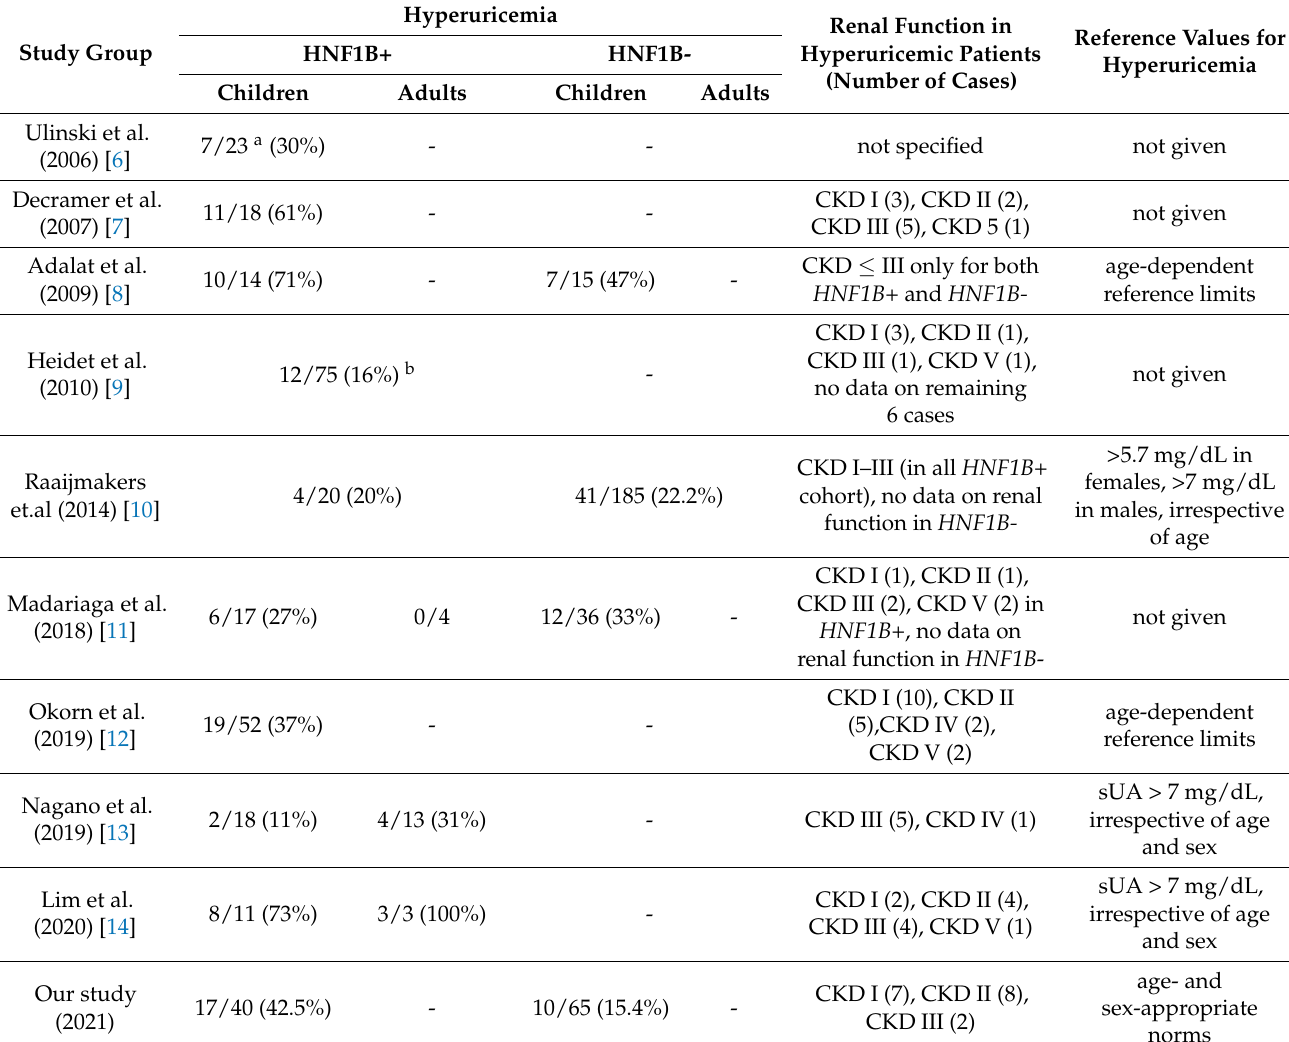
Table 5. Literature overview of the frequency of hyperuricemia in different patient cohorts. Hyperuricemia